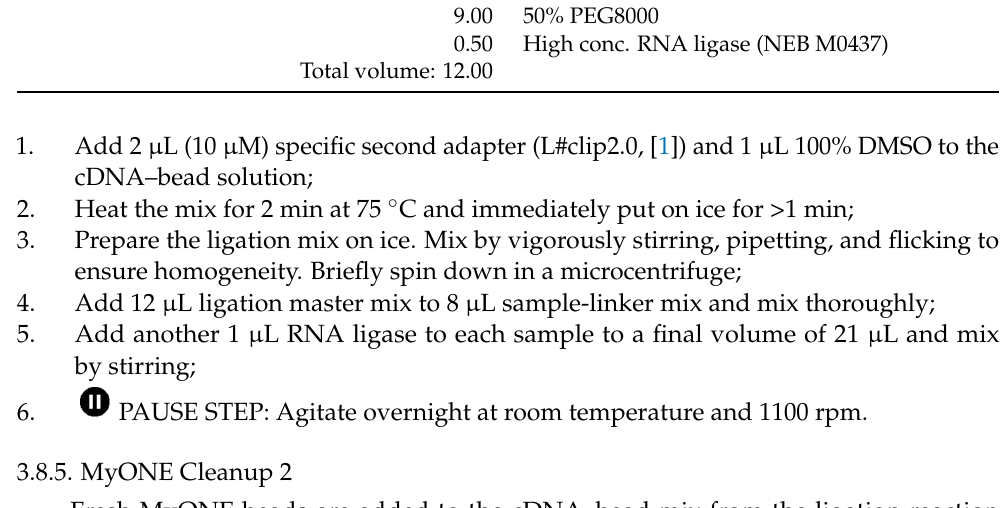
Table 10. PCR Mix for cDNA Preamplification.